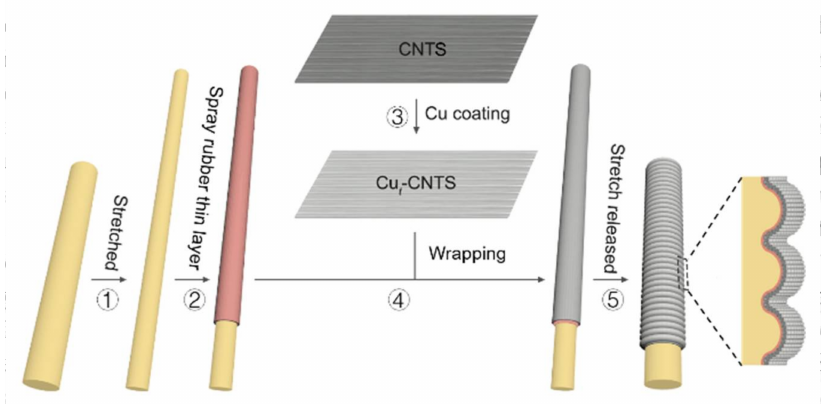
Figure 1. Schematic demonstration of fabrication of (Cu t -CNTS) m @fibers. The numbers indicate the fabrication steps.